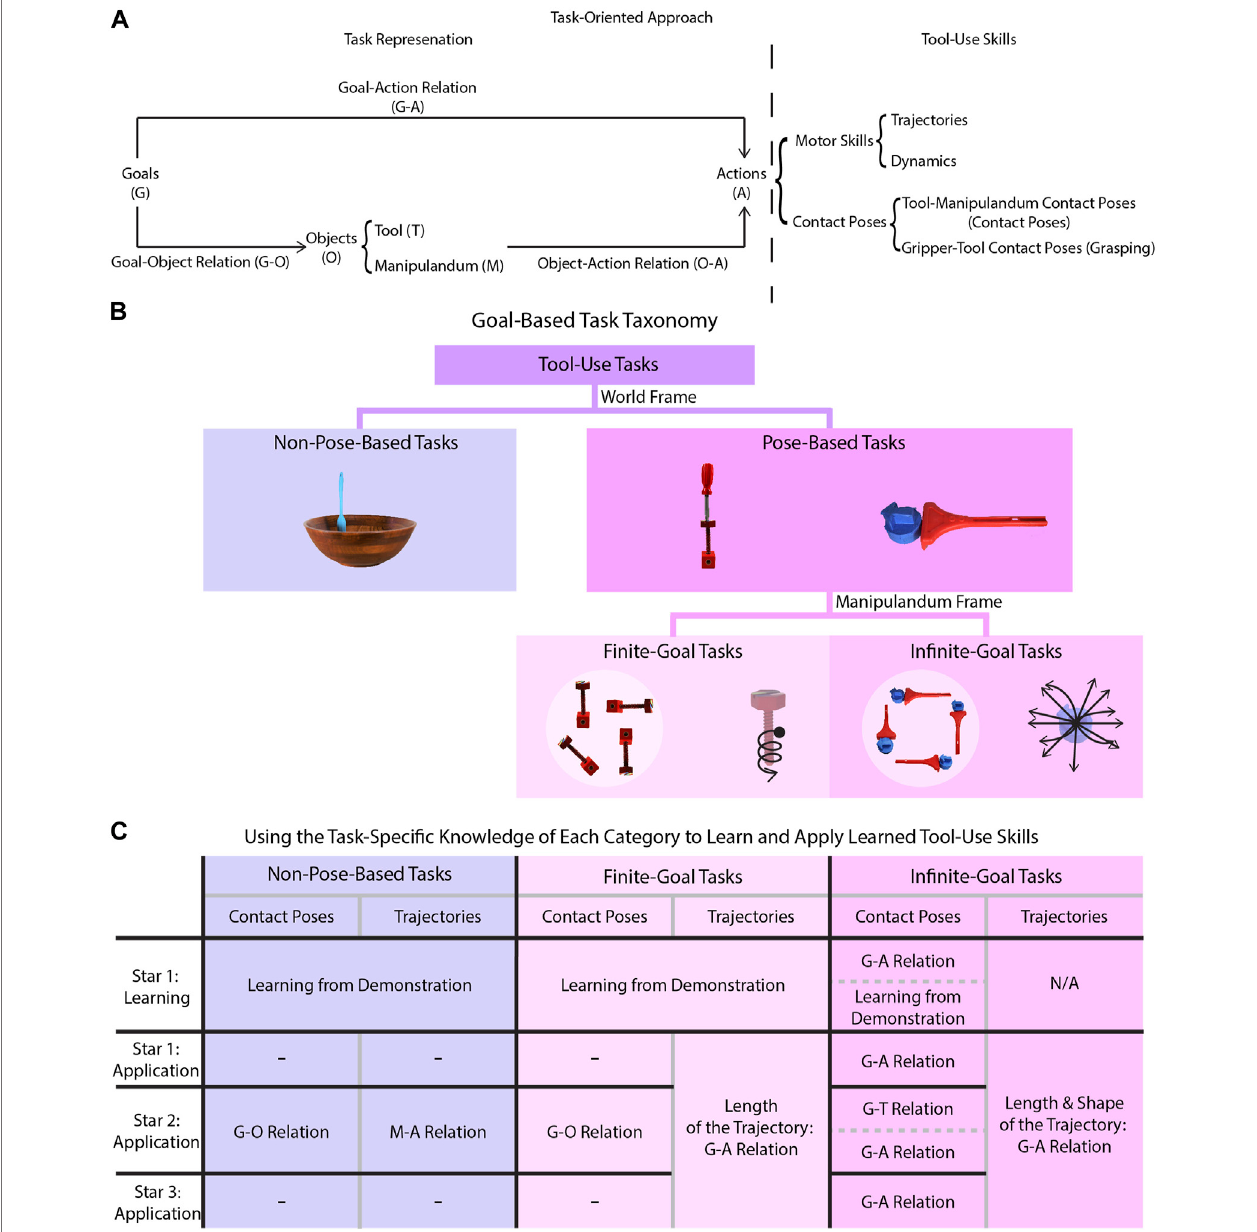
FIGURE 1 | Algorithm overview. (A) is a diagram depicting the task-oriented approach to tool-use skill learning and application. The causal relations between the goals, objects, and actions are represented by the directed edges of the diagram. (B) depicts the task taxonomy whose structure emerges when observing goal-based motionprimitivesfromdifferentframesofreference. (C) isachartsummarizingtaxonomicknowledgeforeachcombinationoftaskcategoryandStarduringthetool-use skilllearningor application process. Each cell speci fi esthespeci fi ctask-speci fi cknowledge relation needed,ifany,denoted bytheabbreviationsG,O,A, T,and M de fi ned in (A)